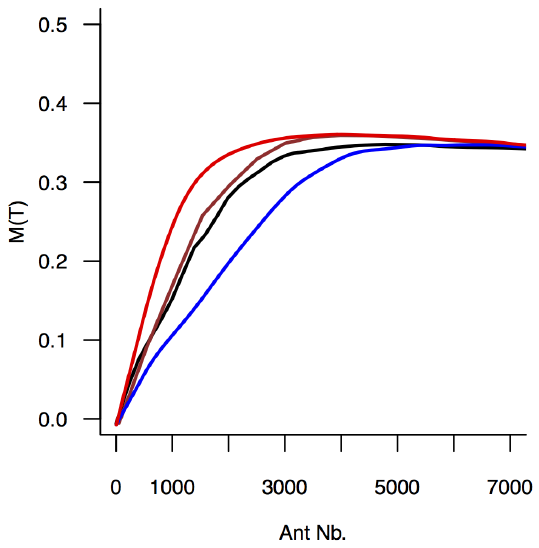
Figure 6. Meshedness M ( t ) at the end of experiments as a function of the number of workers, predicted by the simplified model in a space with no boundary, either using the set of median values of parameters (brown line), picking randomly a parameter set among the experimental ones (black line), or using the set of median values but with the highest lateral nodes formation rate value (red line) or the lowest one (blue line). The number of workers was repeatedly picked uniformly between A=1 and A=7,000 for each condition and the lines report the corresponding tendency obtained by a lowess procedure (see Fig. S5). The meshedness increases as the number of workers increases, from tree-like structures ( M ( t ) ~ 0 ) towards triangular networks ( M ( t ) ? 1 ) up to a saturation value. The predictions including the experimental variance of parameter estimations (black lines) show that the transition of M ( t ) induced by the increase of A is robust to behavioural